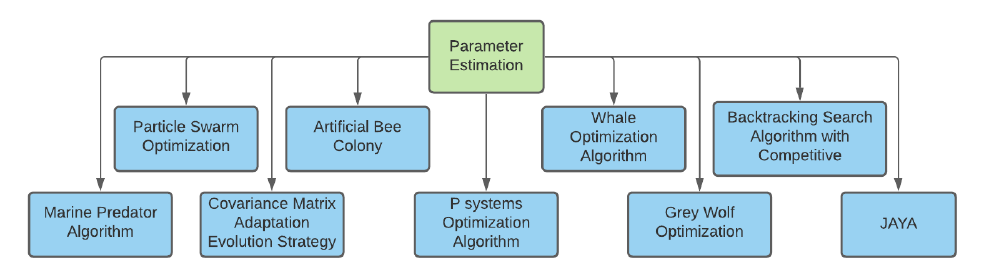
Figure 6. Taxonomy of most used metaheuristics for parameter